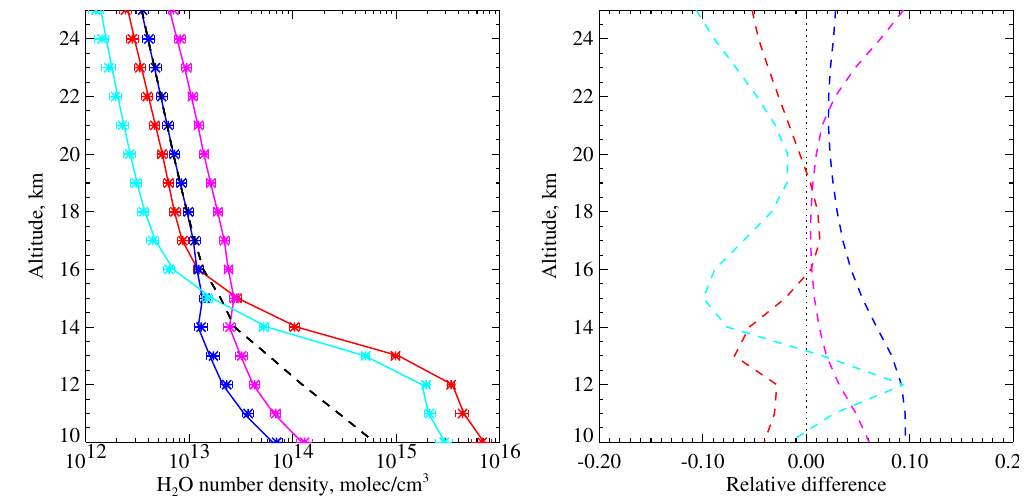
Fig. 9. Same as Fig. 8 but for the true profiles convolved with the corresponding averaging kernels.